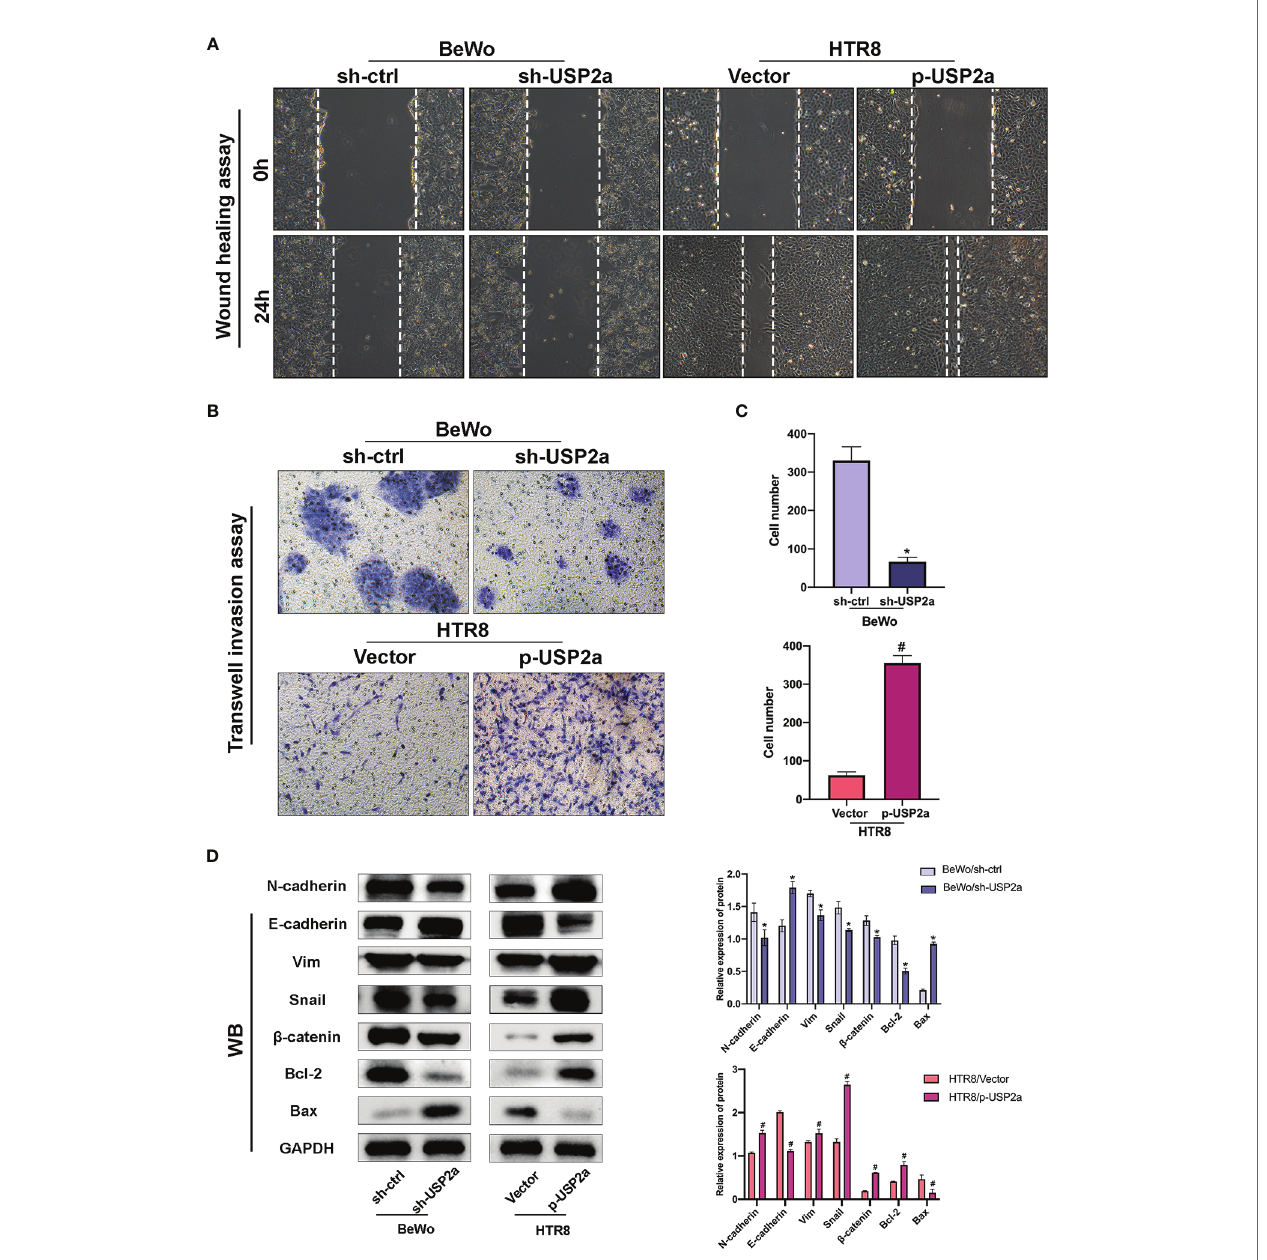
FIGURE 3 | Effects of USP2a on the invasion and migration of trophoblast cells using the Transwell invasion assay and the wound-healing assay. (A) Wound healing scratches were imaged immediately and 24 h after initial scratch time to quantify relative migration. (B) After transfection, BeWo or HTR8 cells (in serum ‐ free medium) were seeded into inserts and incubated for 48 h for invasion assay. Cells at the lower surface of the membrane were counted and analyzed under a light microscope in fi ve random fi elds. The staining intensity was quanti fi ed using the ImageJ software. Graphs show the means ± SD. (C) Western blot Graphs show the mean ± SD. Quantitative analysis of the average invasive cell numbers in each group. (D) The levels of E-cadherin, N-cadherin, Vimentin, Snail, b -catenin, Bax, and Bcl2 were measured using western blotting and quantitative analysis of the proteins was performed. * P < 0.05 vs. sh-Ctrl # P < 0.05 vs control vector, original magni fi cation: ×100 (A) ×200 (B)